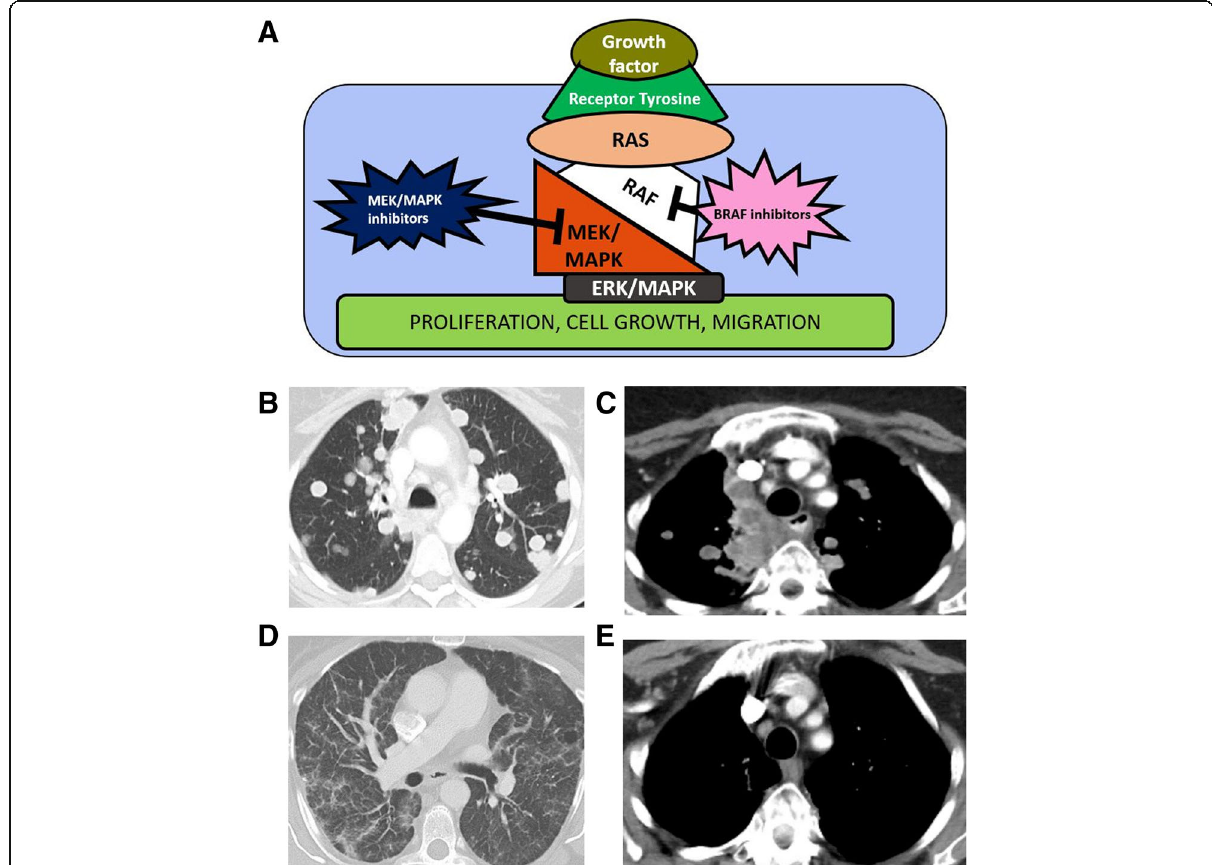
Fig. 4 RTK-RAS pathway. a Image showing the activation of the MAPK transcription factor by binding of growth factor to a transmembrane receptor tyrosine kinase. The resulting signaling cascade culminates with translocation of ERK/MAPK to the nucleus, where ERK activates transcription factors that ultimately result in cell growth. BRAF inhibitors, such as dabrafenib, block RAF signal and MEK/MAPK inhibitors, such as trametinib, block the MEK/MAPK signal. a – d Contrast-enhanced CT images of the chest of a 52-year-old woman with BRAF V600 mutant melanoma, progressed on ipilimumab, treated with dabrafenib and trametinib. Baseline ( a , b ) and follow-up CT ( c , d ) performed two months after treatment was started, shows almost complete resolution of multiple lung nodules and mediastinal